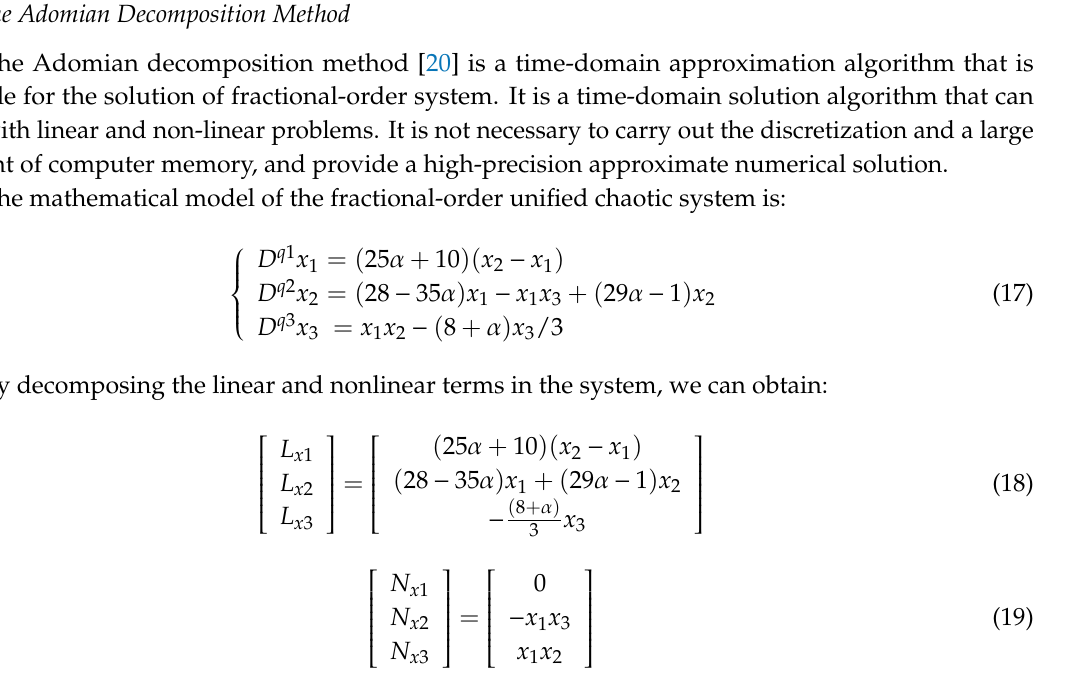
Figure 8. Du ffi ng oscillator phase space diagram when q 1 = q 2 = q 3 = Figure 8. Duffing oscillator phase space diagram when q 1 = q 2 = q 3 = 0.98.